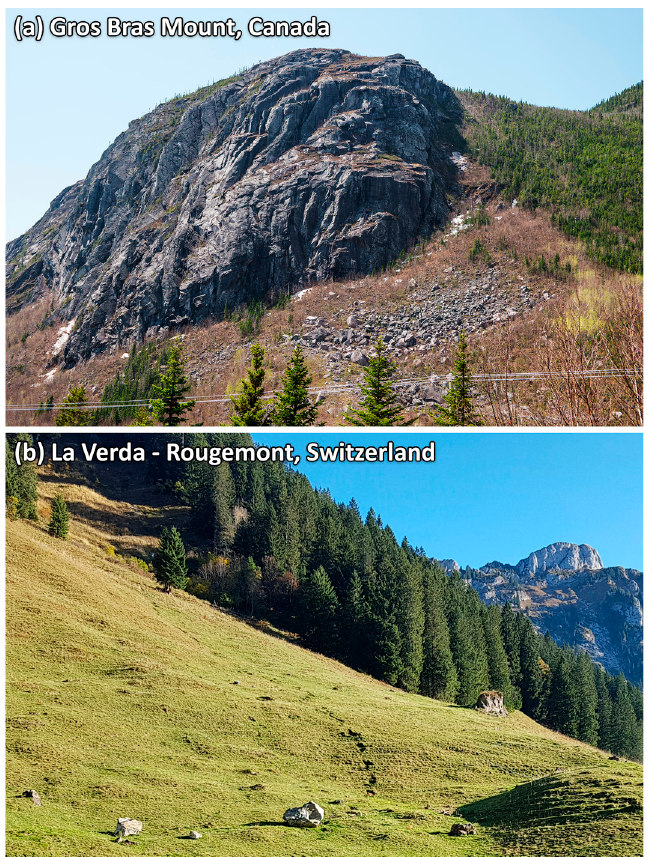
Figure 17. Two real sites where the algorithm was tested to simulate rockfalls. ( a ) Gros Bras Mountains located in Canada. The scree slope composed of many large rock fragments is clearly visible. ( b ) Moderately steep alpine slope near La Verda–Rougemont in Switzerland. Impact marks and boulders from a 2019 rockfall event and older events are visible. The forest has stems of 57 cm DBH on average (Std Dev of 23 cm).